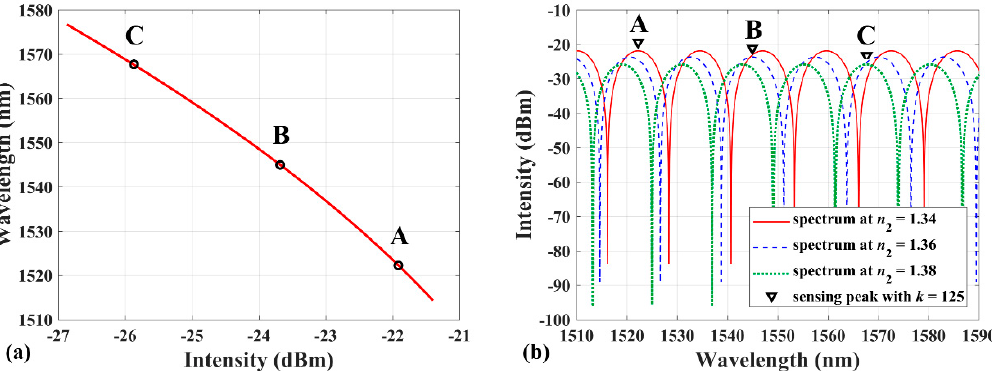
Figure 2. ( a ) Relationship between the sensing peak wavelength and the interference maximum intensity and ( b ) interference spectrum at n 2 = 1.34, 1.36, and 1.38, respectively. The marked points A, B, and C represent the same sensing peak ( k = 125); the parameters L = 71 µ m, I in = 1 mW, n 1 = 1.45205; and n 2 changes from 1.333 to